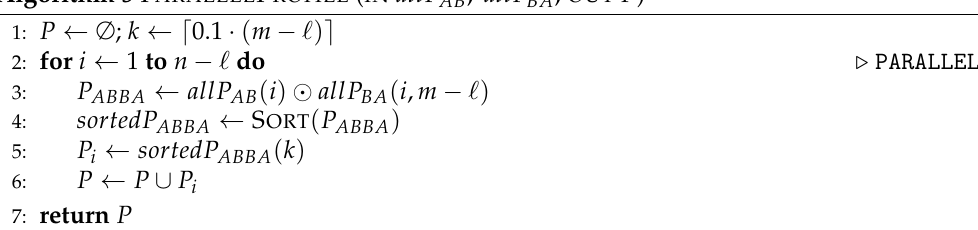
Algorithm 5 P ARALLEL P ROFILE ( IN allP AB , allP BA ; OUT P